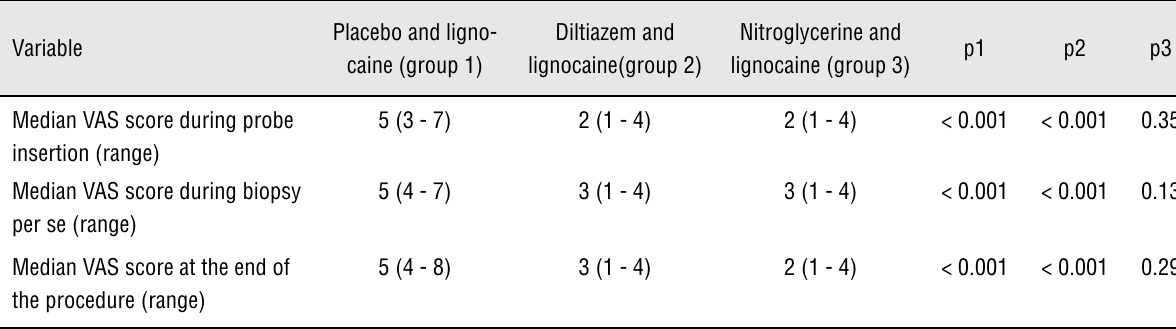
Table 2 - Pain scores in the three groups during transrectal biopsy of the prostate.